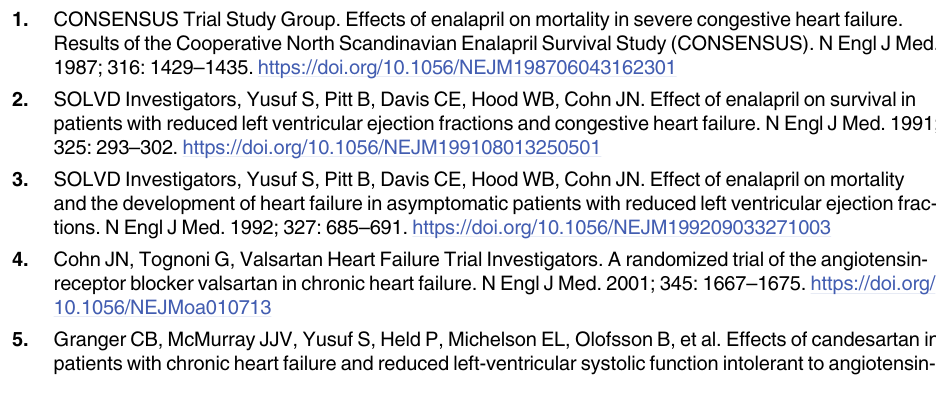
S5 Table. Patient characteristics in those with and without ACE-I/ARB, and propensity score-matching analysis in HFpEF. S6 Table. Results of troponin measurement at admission. S1 Fig. Prescription and uptitration of ACE-I/ARB stratified by LVEF category. S2 Fig. Prescription of ACE-I/ARB and mineralocorticoid receptor blockers stratified by LVEF category. S3 Fig. Cumulative 1-year incidences of clinical outcomes in the three EF groups. S4 Fig. Propensity-score matching analysis and summarized